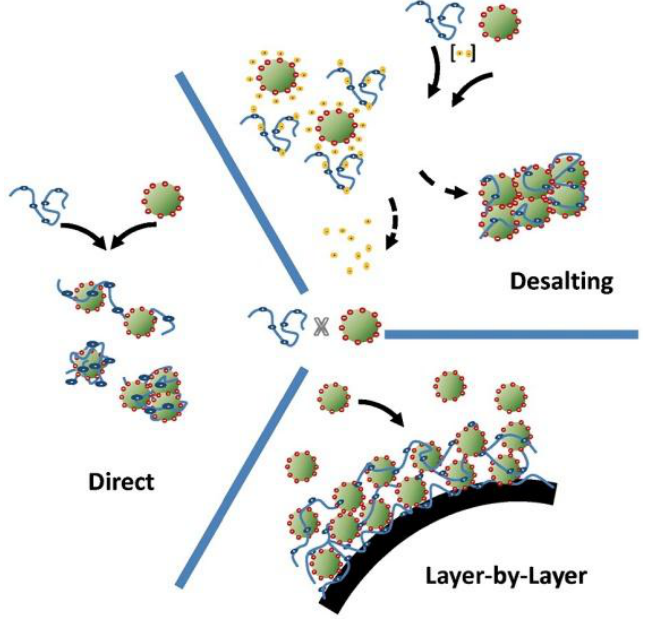
Figure 2. Summary of the three methods to form thin layers of physically attached polymeric chains to inorganic particles by taking advantage of charge. Reprinted with permission from [16]. Copyright 2012,